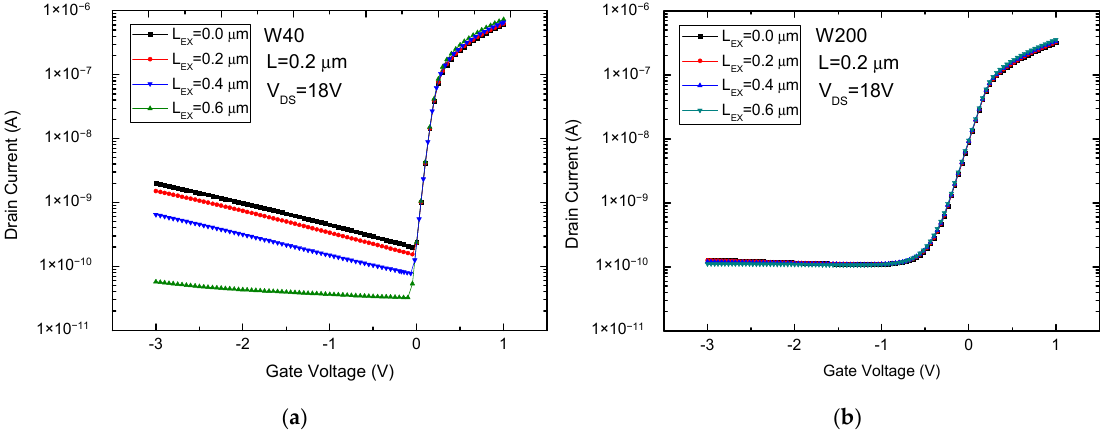
Figure 4. Subthreshold characteristics of ( a ) W40 and ( b ) W200 with various L EX at V DS = 18 V.